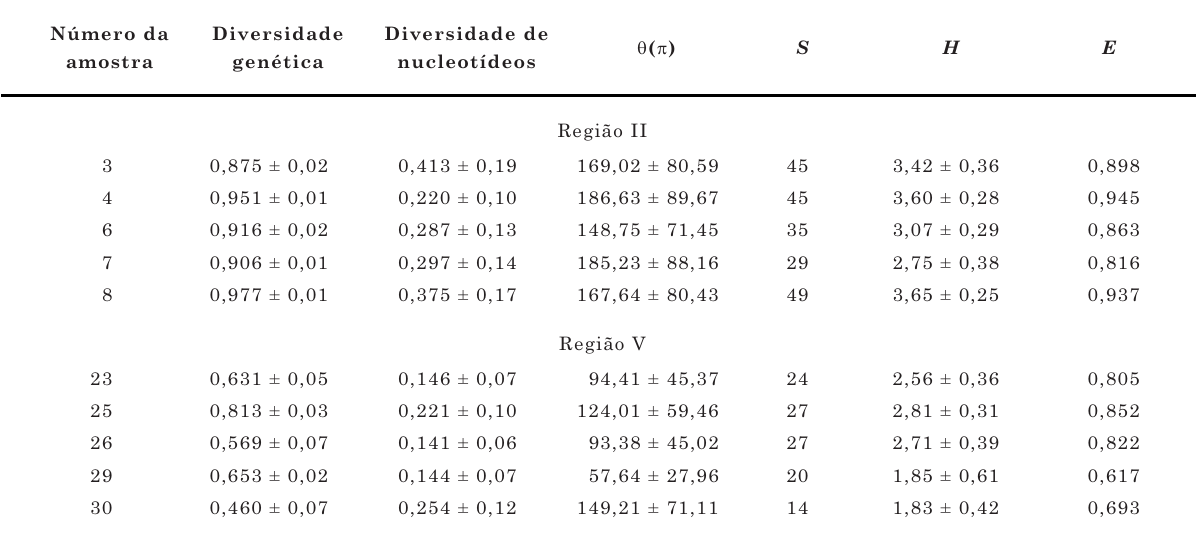
(Figura 4). Por meio deste, pode-se observar a presença de quatro grupos distintos, formados de acordo com a região geográfica da qual as amostras foram retiradas. o grupo II, pelas amostras 4 e 5 (região II); o grupo III, pelas amostras 23 e 25 (região V); e o grupo IV, pelas amostras 26, 29 e 30 (região V).